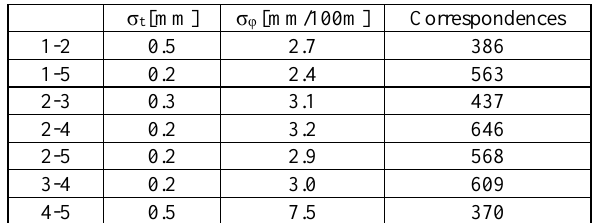
Figure 7. Orthophoto of the town hall’s front façade.